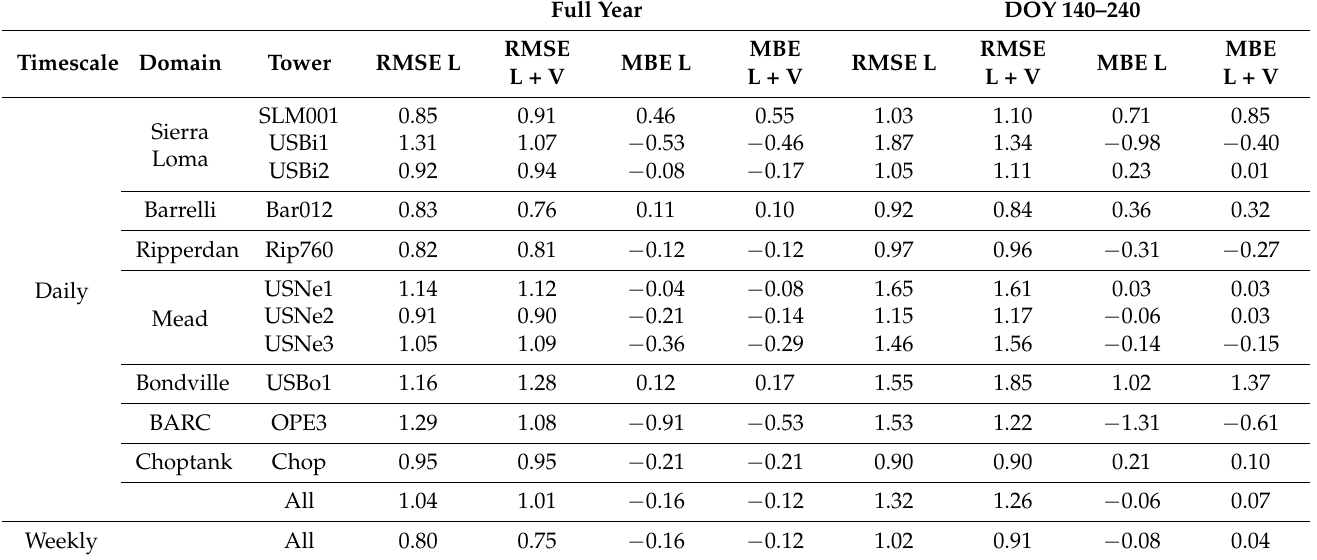
Table 2. Statistical metrics of model performance (RMSE and MBE) for estimating ET (mm d − 1 ) at daily and weekly timesteps with Landsat-only (L) and Landsat + VIIRS-S2 (L+V), over the full year of 2018 and the peak growing season (DOY 140–240) by tower and for all towers